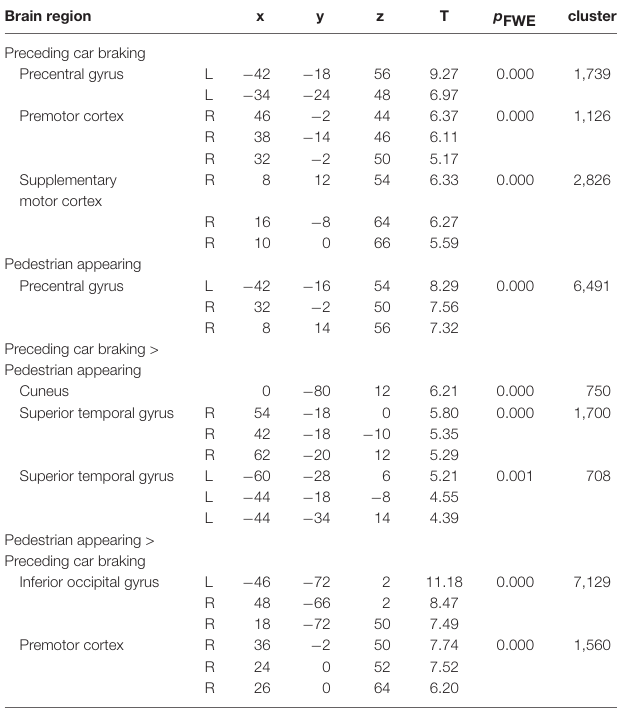
TABLE 3 | Brain regions predicting the braking response to a preceding car slowing down or a crossing pedestrian. Brain region x y z T p FWE cluster Preceding car Positive correlation no suprathreshold clusters Negative correlation no suprathreshold clusters Pedestrian crossing Positive correlation Posterior superior